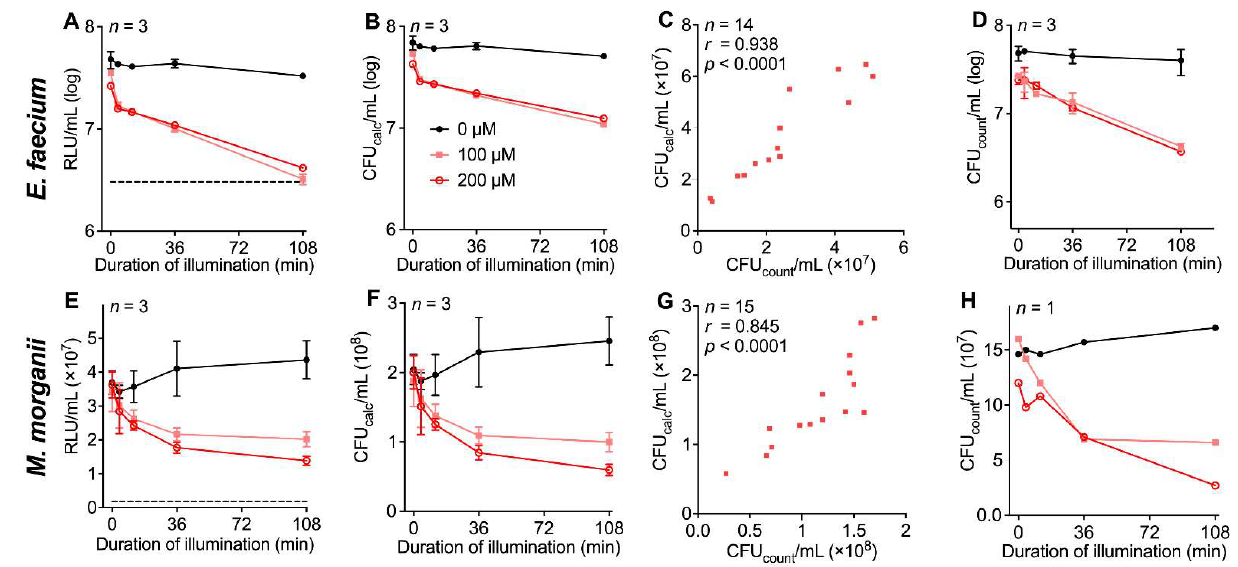
Figure 6. Correlation of calculated and manually detected bacterial density for THPTS-based aPDI in different bacterial types. THPTS was illuminated with 18 mW/cm 2 resulting in 0 J/cm 2 (0min), 4.3 J/cm 2 (4min), 12.9 J/cm 2 (12 min), 38.9 J/cm 2 (36 min), 116.6 J/cm 2 (108 min) at λ cent =760 nm. Dashed line indicates the luminescence of heat-inactivated bacteria. ( A ) ATP-induced luminescence by VRE E. faecium after aPDI. ( B ) Calculated bacterial density of VRE E. faecium based on luminometric measurements. ( C ) Correlation between calculated and manually determined bacterial density in VRE E. faecium ; r = correlation coefficient. ( D ) Manually counted bacterial density of VRE E. faecium after aPDI. ( E – H ) Results for M. morganii as described above for E. faecium .